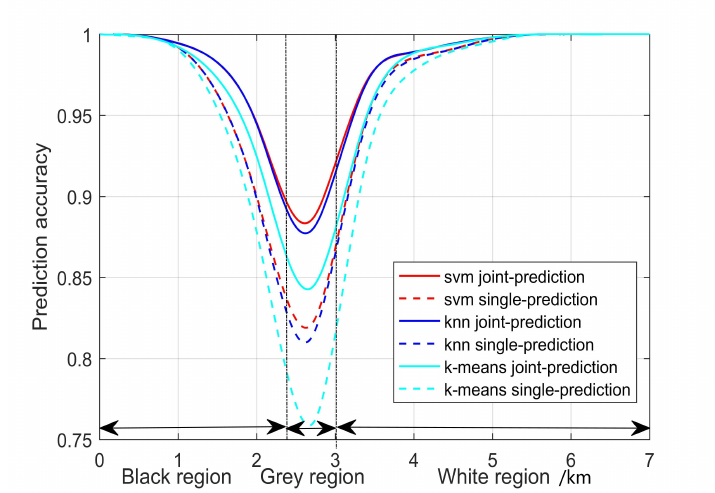
Figure 9. Prediction accuracy of different machine learning (ML)